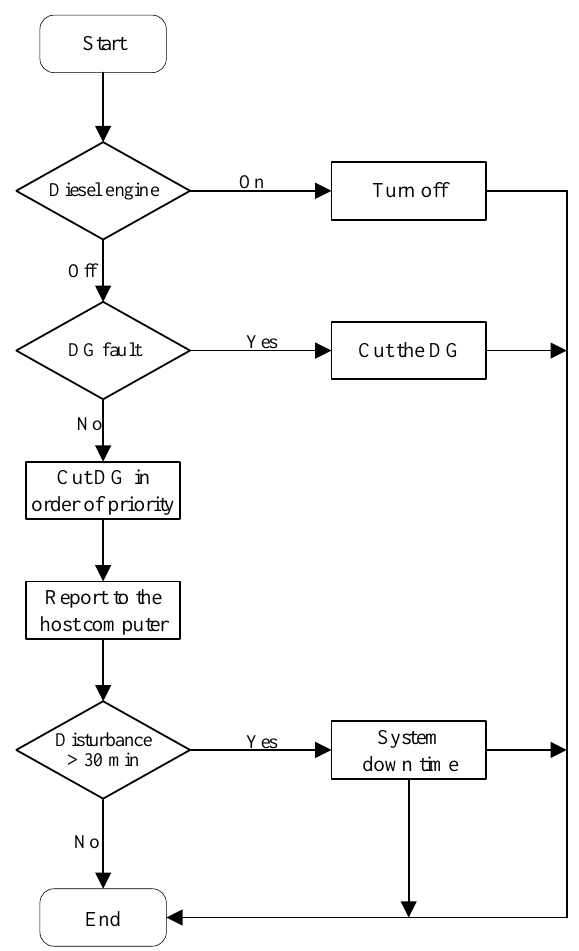
Figure 4. CH zone frequency control strategy.